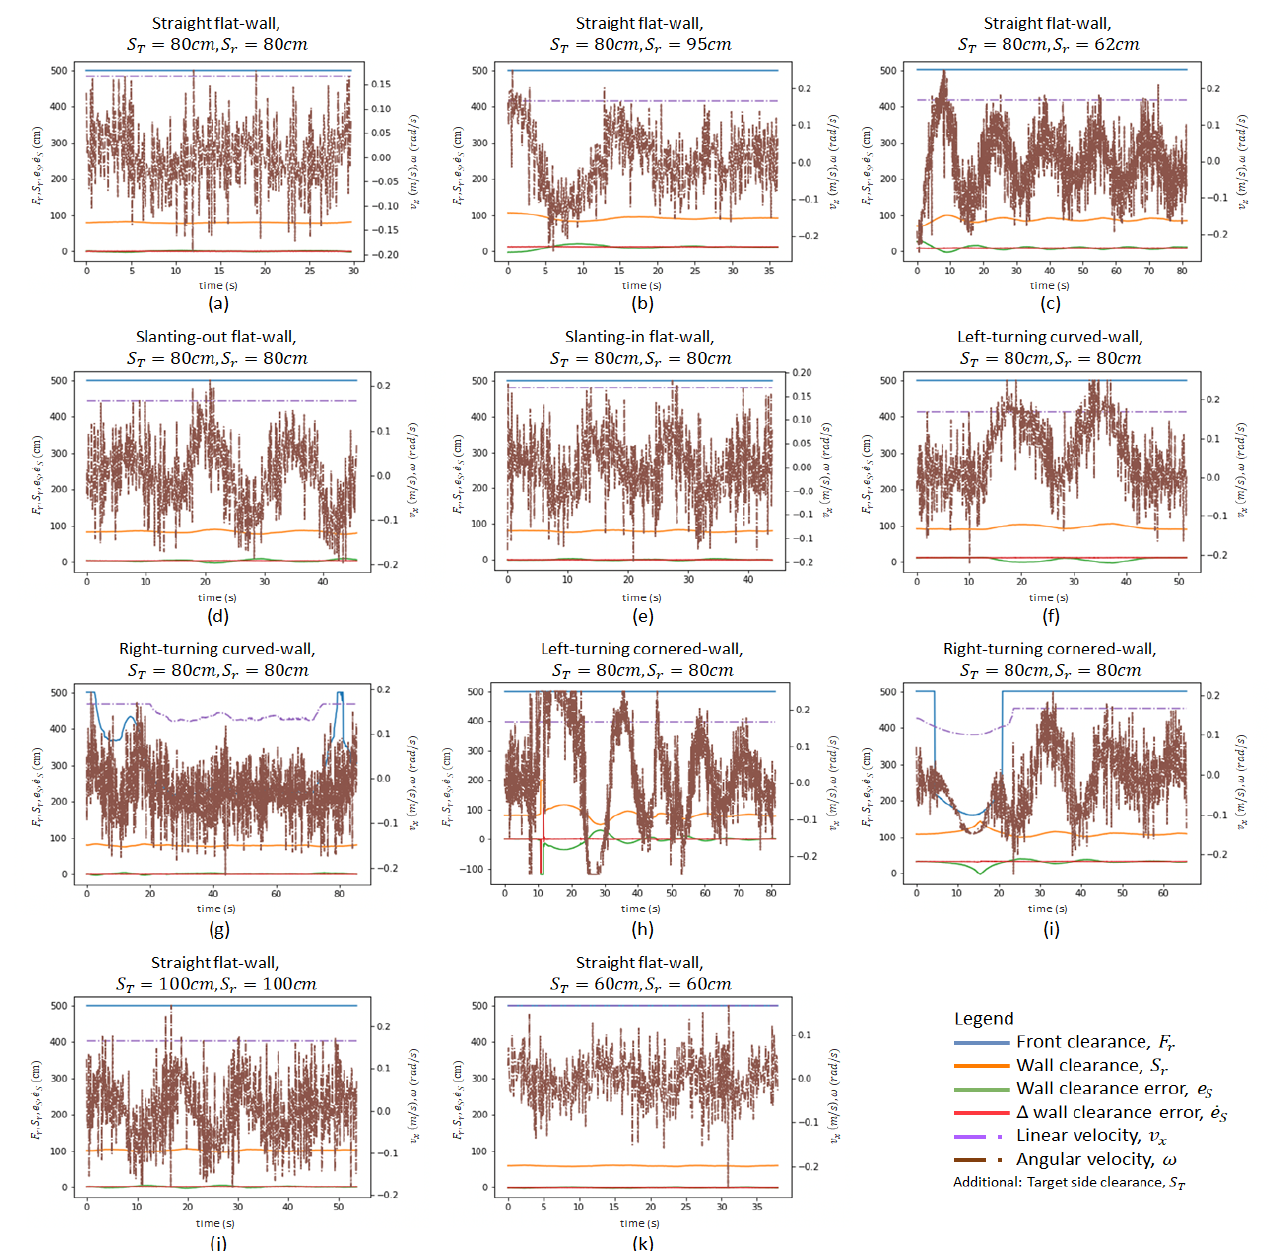
Figure 10. Variation of crucial parameters of the controller. ( a – c ) show flat-walls experiments with different initial positions, ( d , e ) for slanting-wall experiments, ( f , g ) for curved-wall experiments, ( h , i ) for cornered-wall experiments, ( j , k ) for flat-wall experiments with different target side